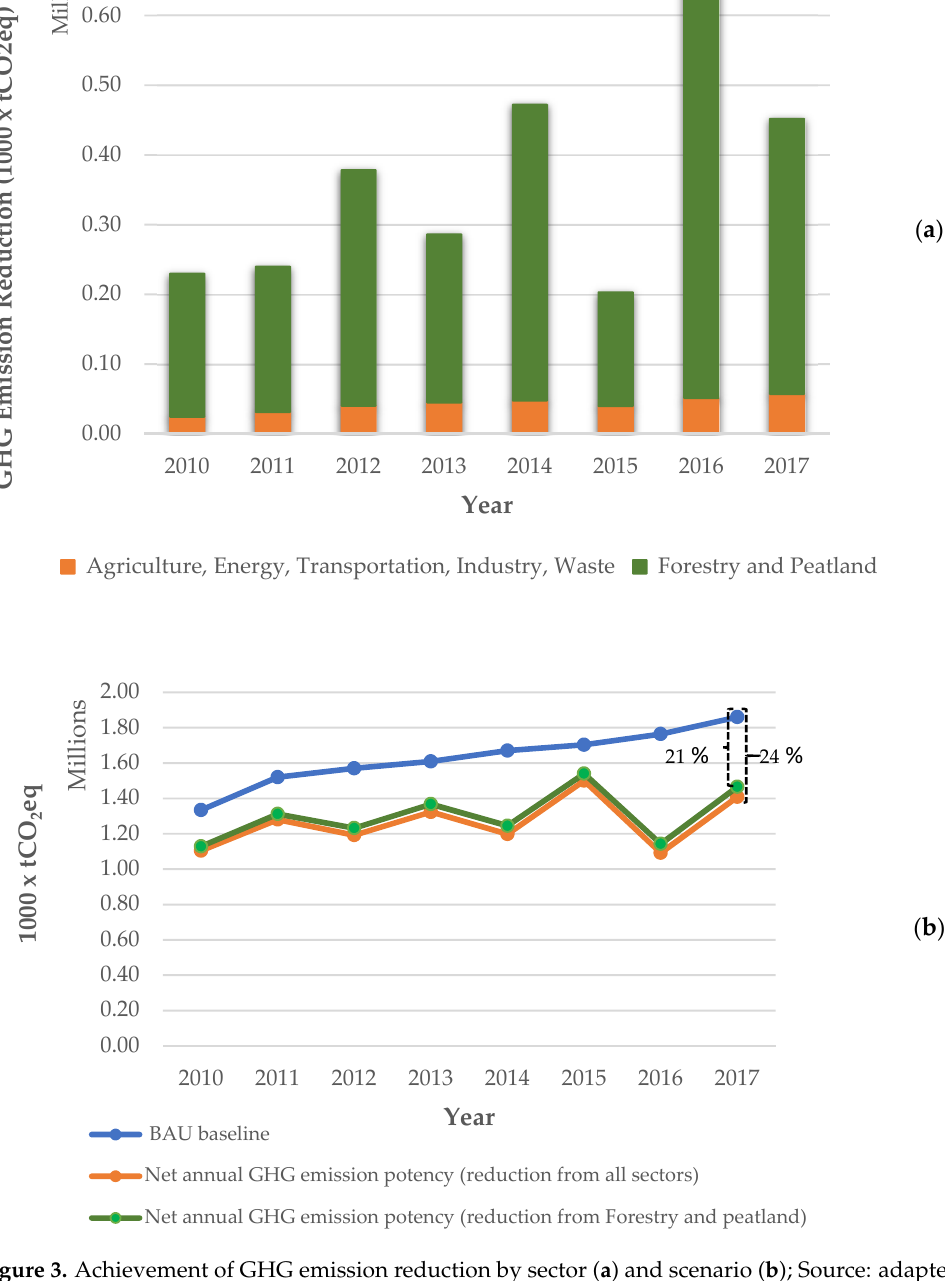
Figure 3. Achievement of GHG emission reduction by sector ( a ) and scenario ( b ); Source: adapted from MoNDP [177] .